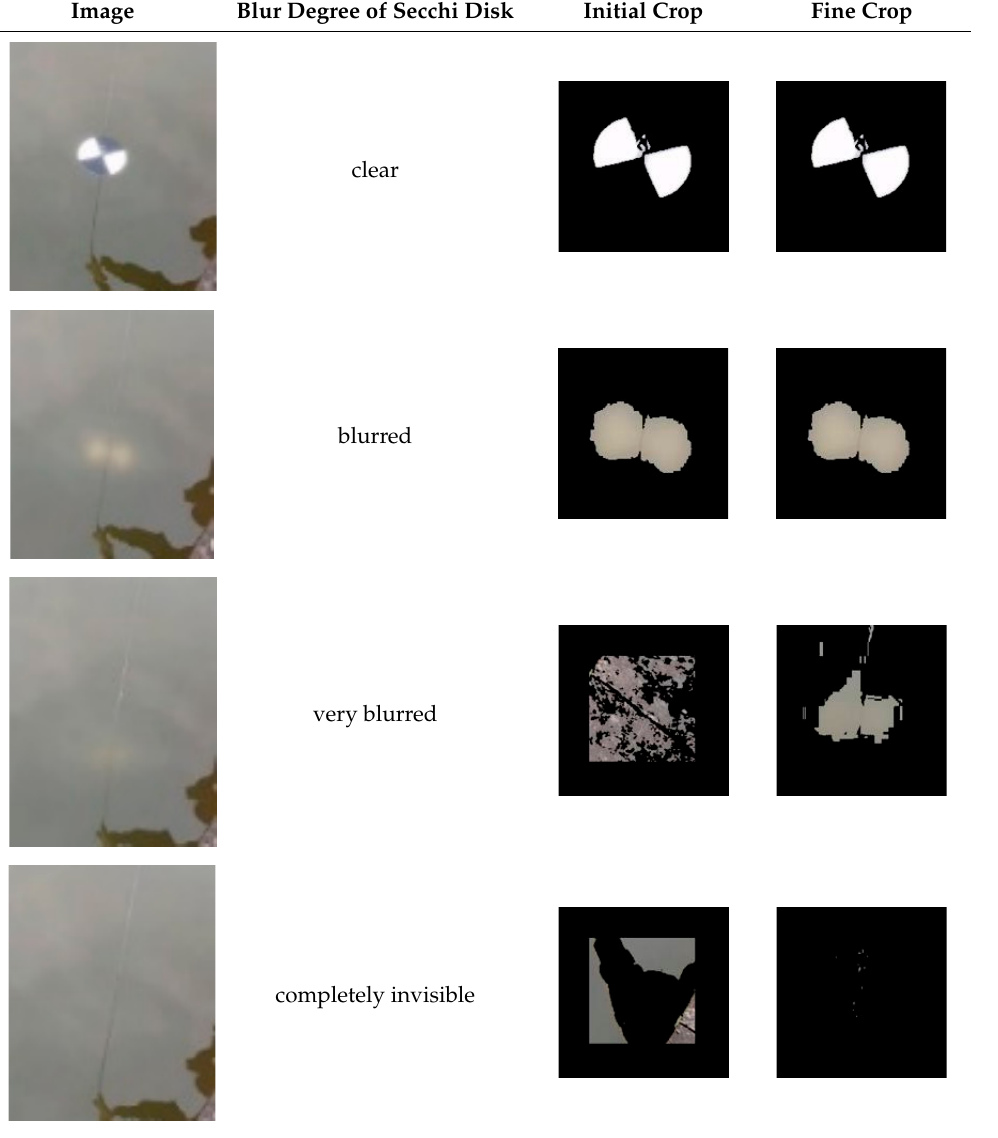
Table 2. The results from cropping the white part of the Secchi disk.